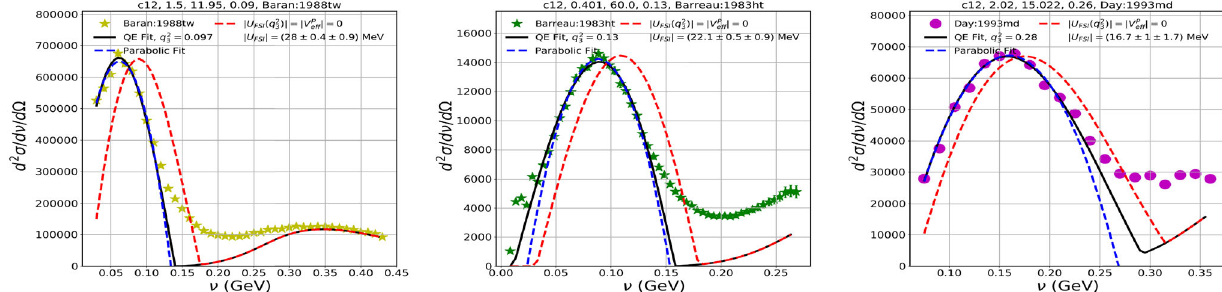
= 0 . 221 GeV) QE differential cross C ( k P F 6